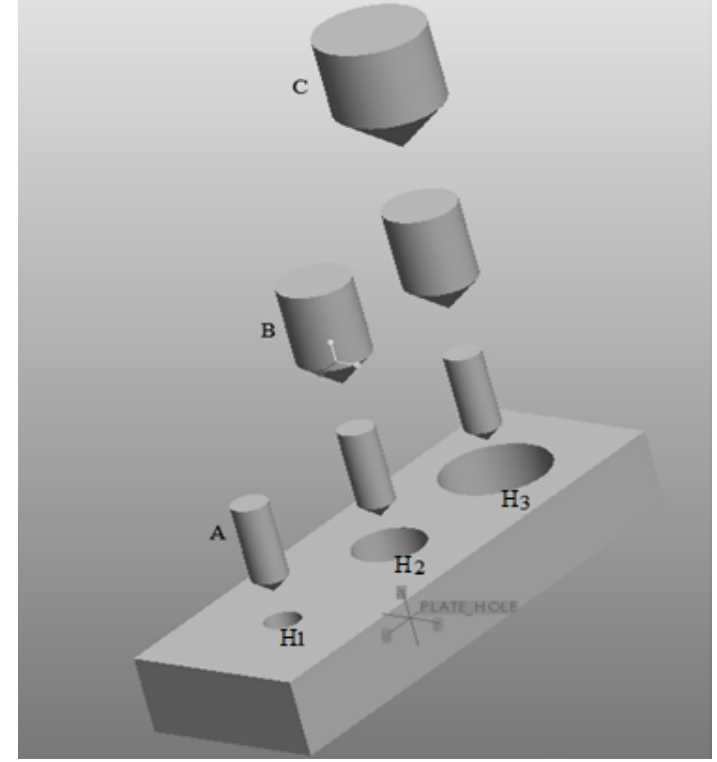
Fig. 1. Image showing various tool combinations required to drill a hole on